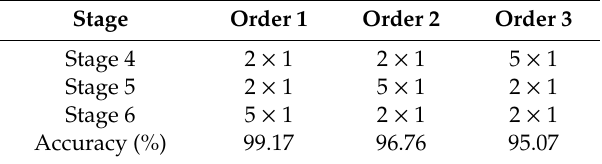
Table 6. Fault diagnosis results of pooling layers with different orders.